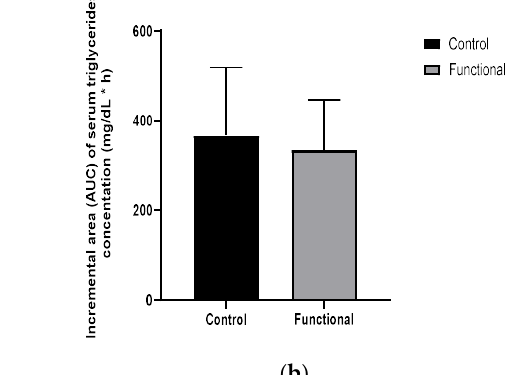
( b ) Figure 5. ( a ) Incremental changes in aggregation in PRP (cm) . ( b ) The incremental area under the curve (iAUC) for aggregation in PRP (cm × h). A time effect was detected for postprandial LDL-cholesterol levels ( p = 0.02), but no one treatment × time interaction was found. The LDL-cholesterol levels were significantly reduced 3h after the functional meal consumption ( p = 0.043) when compared to the baseline, while a non-significant raise was found 3 h after the control meal compared to the baseline concentration. No statistically significant interactions or differences were observed regarding the remaining biomarkers tested (total cholesterol, HDL-cholesterol, and uric acid), as there was a similar response to the levels of these biomarkers after consuming both meals. The postprandial changes in serum total, HDL- and LDL- choles- terol, glucose, and uric acid are presented in Figure 6.